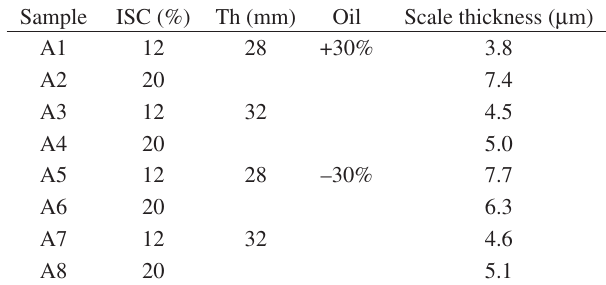
Table 3. Oxide Scale thickness and its respective processing parameters. Sample